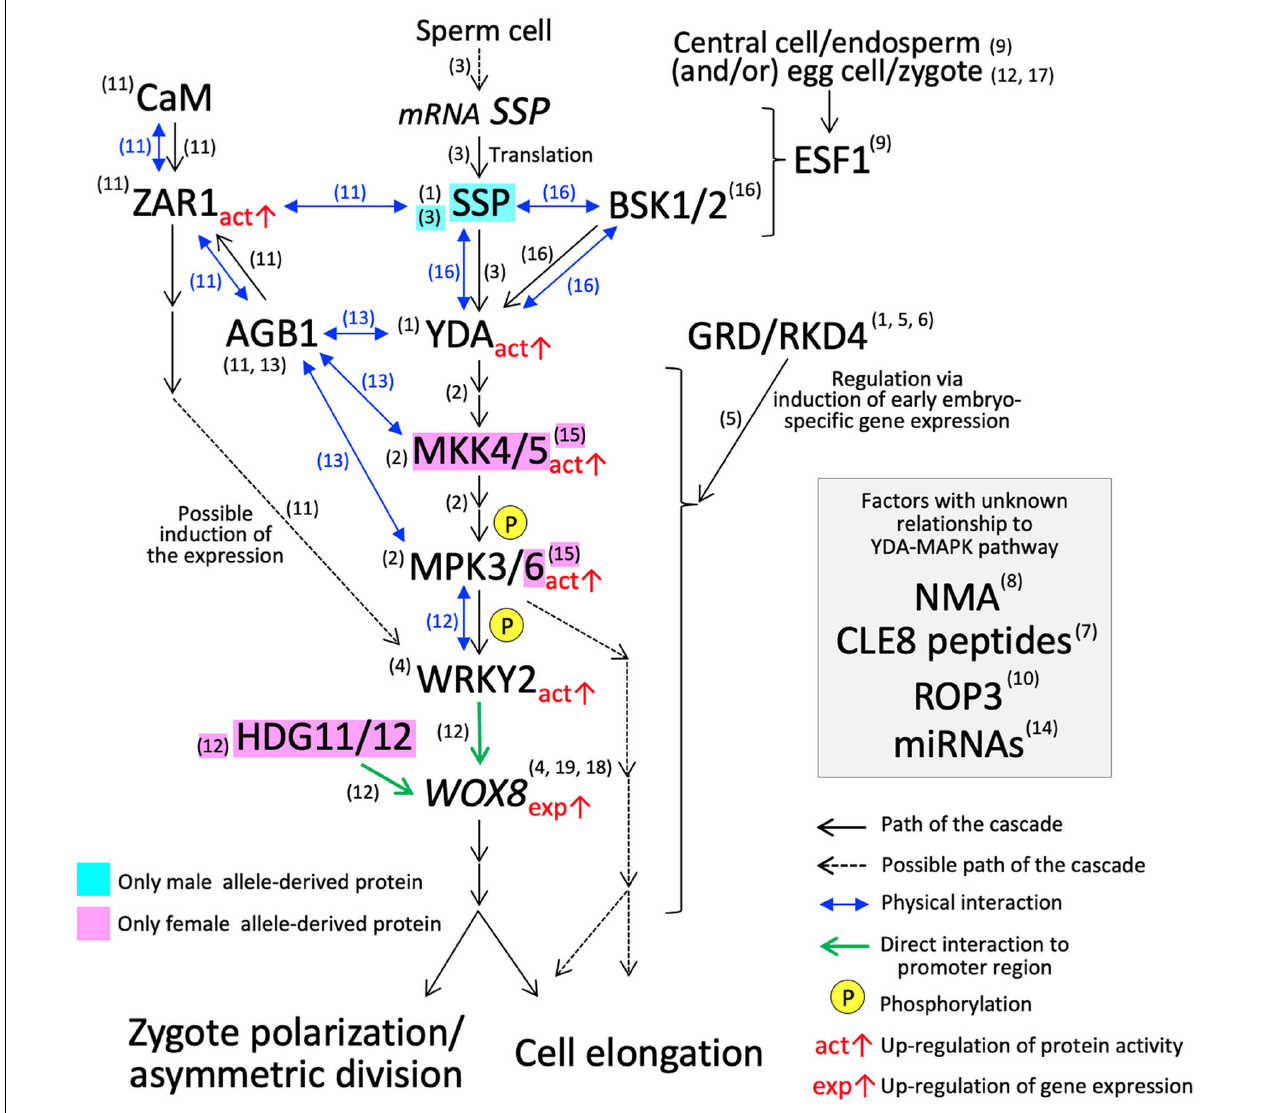
FIGURE 2 | YDA-MAP cascade responsible for the cell elongation and asymmetric cell division in Arabidopsis zygote. The numbers in parentheses indicate the reference which describes the step of the pathway; (1) Lukowitz et al., 2004; (2) Wang et al., 2007; (3) Bayer et al., 2009; (4) Ueda et al., 2011; (5) Jeong et al., 2011; (6) Waki et al., 2011; (7) Fiume and Fletcher, 2012; (8) Babu et al., 2013; (9) Costa et al., 2014; (10) Huang et al., 2014; (11) Yu et al., 2016; (12) Ueda et al., 2017; (13) Yuan et al., 2017; (14) Armenta-Medina et al., 2017; (15) Zhang et al., 2017; (16) Neu et al., 2019; (17) Bayer et al., 2017; (18) Haecker et al., 2004; (19) Breuninger et al.,